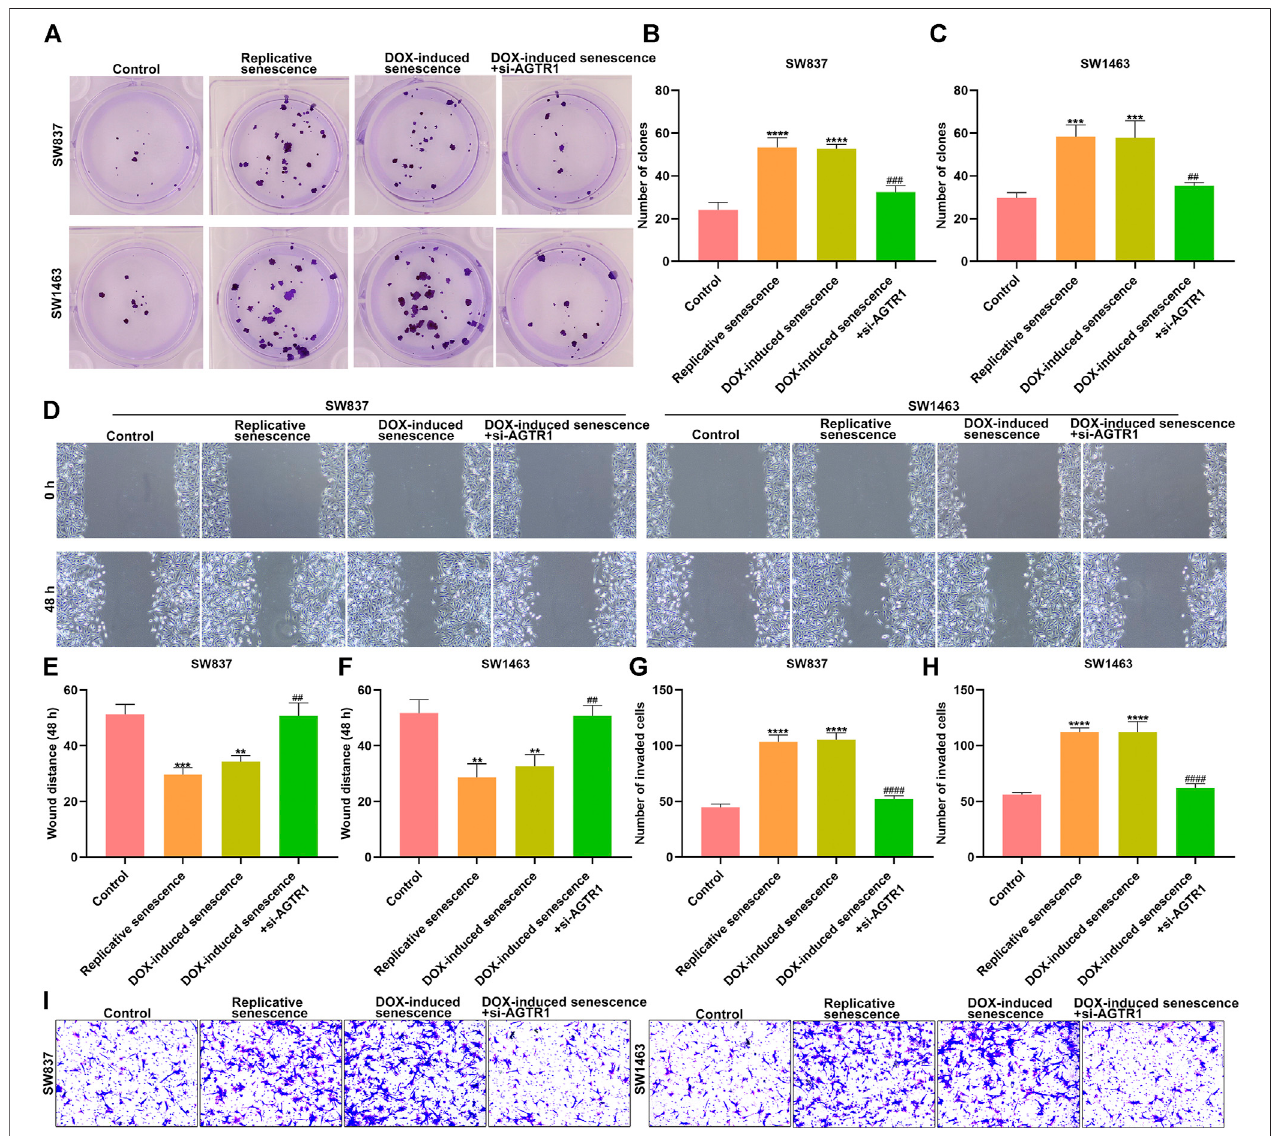
FIGURE 10 | Silencing AGTR1 suppresses senescent stromal cell-triggered rectal cancer progression. (A – C) Colony formation assay was presented for investigating proliferation of SW837 and SW1483 rectal cancer cells co-cultured with the conditioned medium of senescent HUVECs with AGTR1 knockdown. (D – F) Wound healing assay was utilized for examining migration of SW837 and SW1483 cells co-cultured with the conditioned medium of senescent HUVECs with AGTR1 knockdown. (G – I) Transwell assay was presented for examining invasion of SW837 and SW1483 cells cocultured with the conditioned medium of senescent HUVECs with AGTR1 knockdown. Compared with control, ** p < .01; *** p < .001; **** p < .0001. Compared with DOX-induced senescence, ## p < .01; ### p < .001; #### p <